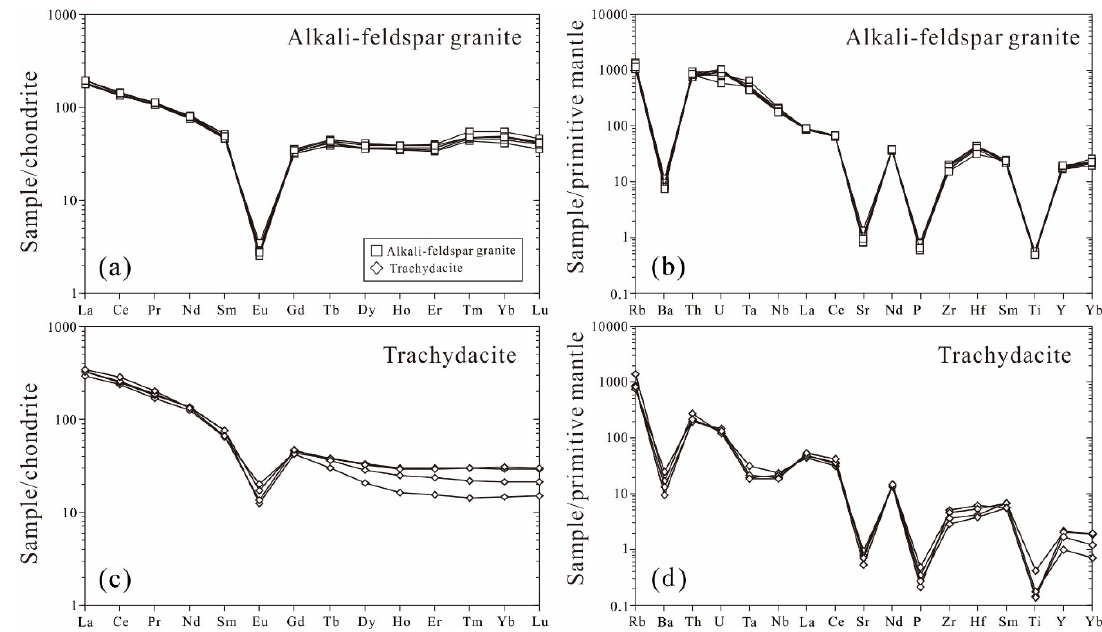
Figure 6. ( a , c ) Chondrite-normalized [31] REE patterns and ( b , d ) primitive mantle-normalized [32] trace element patterns for the Tiantangshan alkali-feldspar granite and trachydacite.